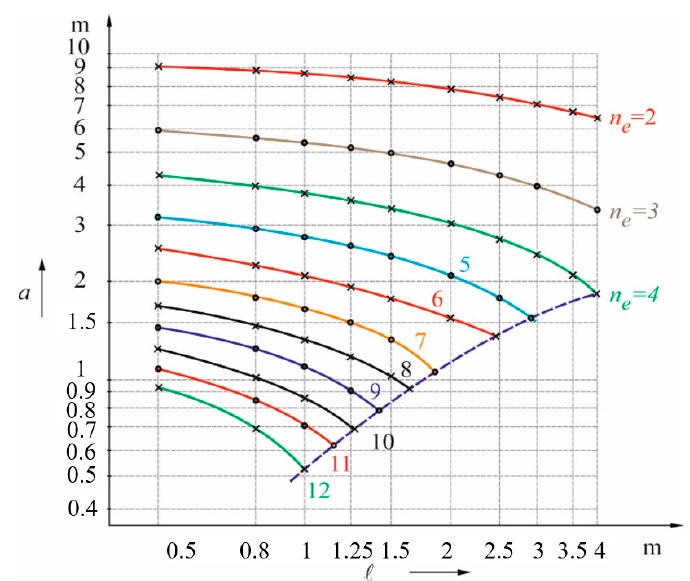
Figure 2. The graph of the function a( ℓ ,ne), having as parameter the number of the electrodes n e , for ρ p = 100 Ω m and R Pn = 4 Ω .